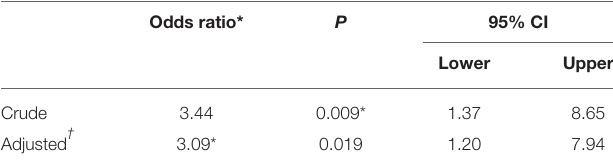
TABLE 3 | Results of conditional logistic regression analysis: odds ratios of disease progression associated with exposure to anesthesia.